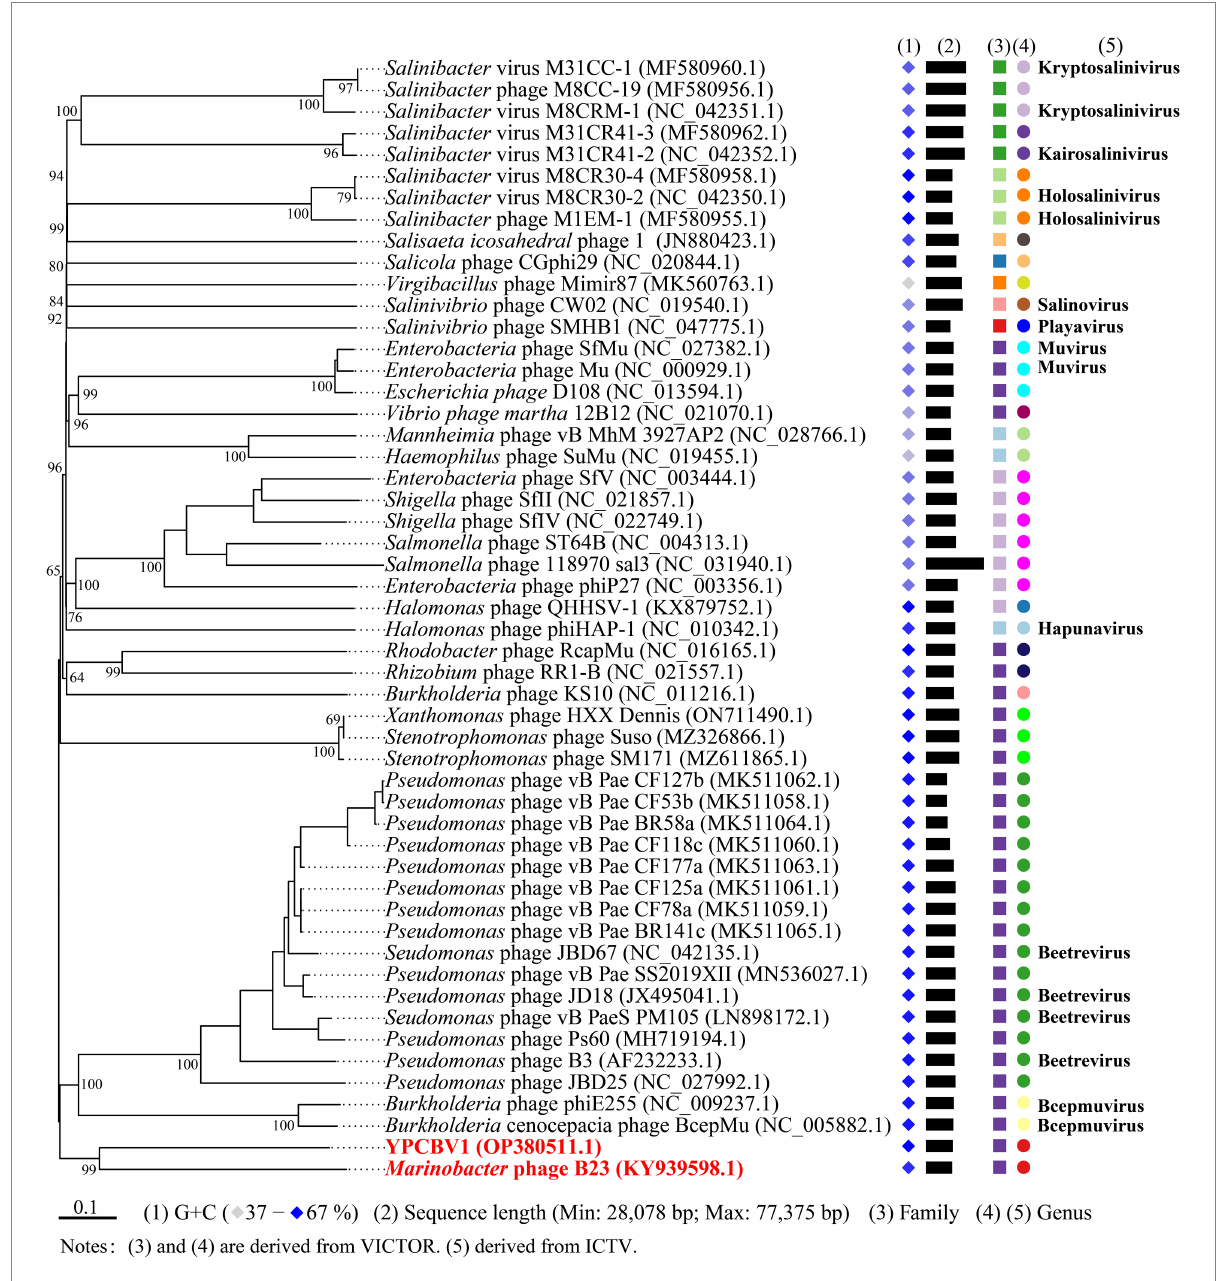
FIGURE 6 Phylogenetic analysis of the genome sequence of YPCBV-1 using VICTOR. The classification of family and genu is derived from VICTOR’s evaluation results. Squares represent families, circles represent genus, and different colors indicate different family/genus. Genus names were derived from ICTV (July 2021). Viruses with no genus name indicate that ICTV is not currently publishing their classification